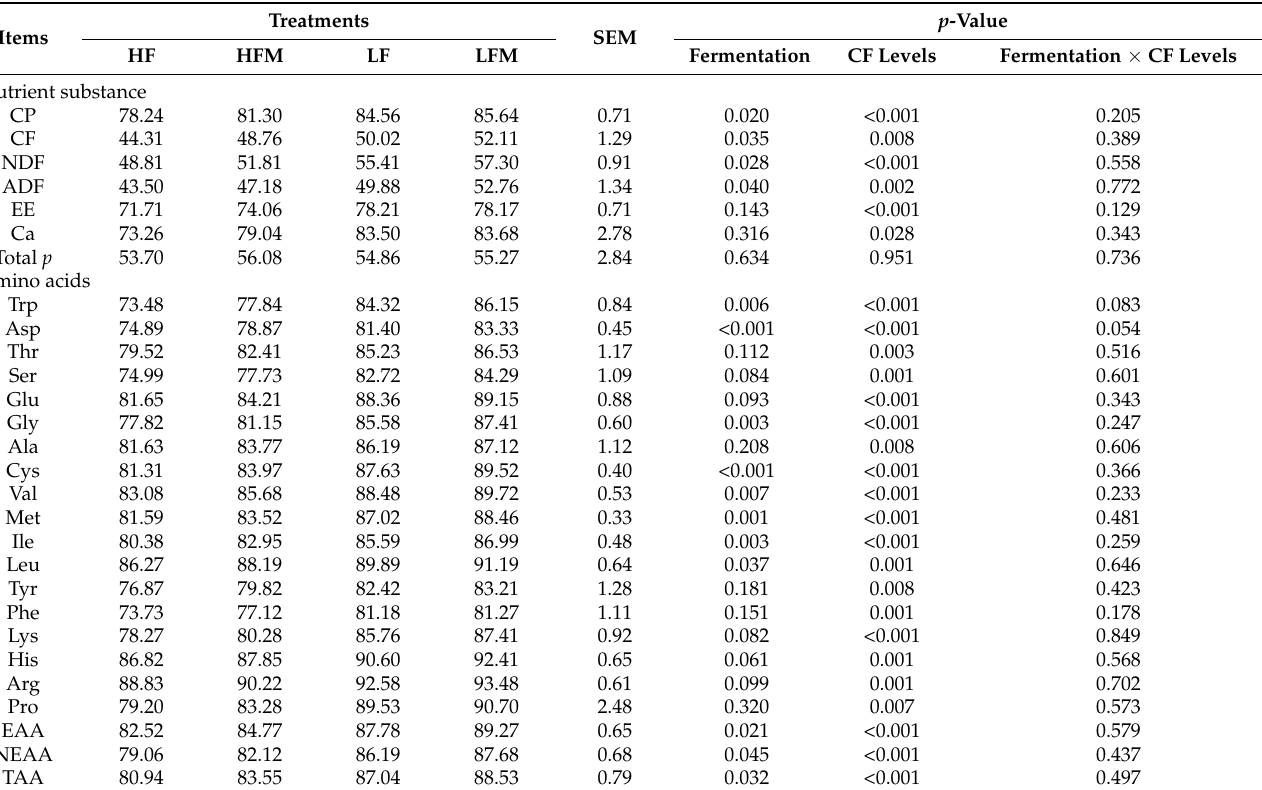
Table 3. Effects of multi-bacteria fermentation and dietary CF level on apparent total tract digestibility (ATTD) of CP, CF, EE, Ca, Total p , and amino acids in finishing pigs